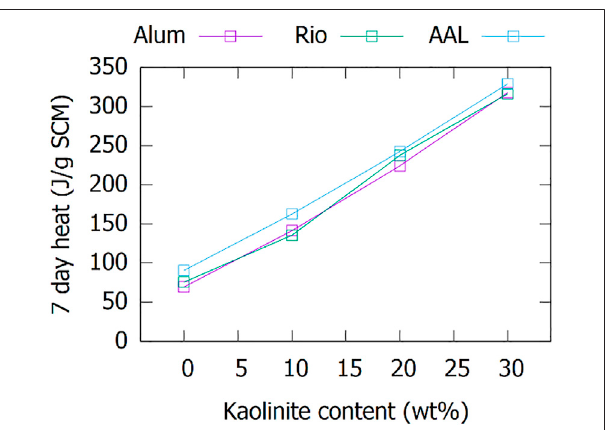
FIGURE3| Boxplotsgivingthecumulativeheatat7daysintheR³testof BR before and after (co-)calcination. FIGURE 4 | Variation with a kaolinite replacement of BR before calcination of the cumulative heat at 7 days in the R³ test.